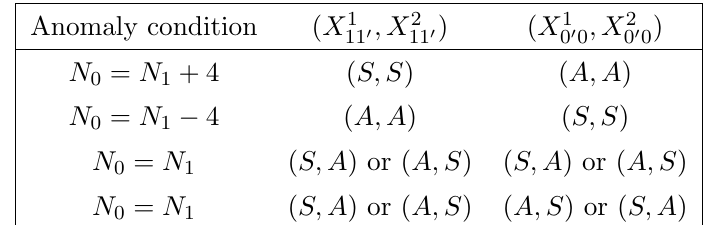
Table 6. The various unoriented projections b (cid:10) of C = Z 0 U( N 1 ).\A" stands for \Antisymmetric representation", while \S" for \Symmetric